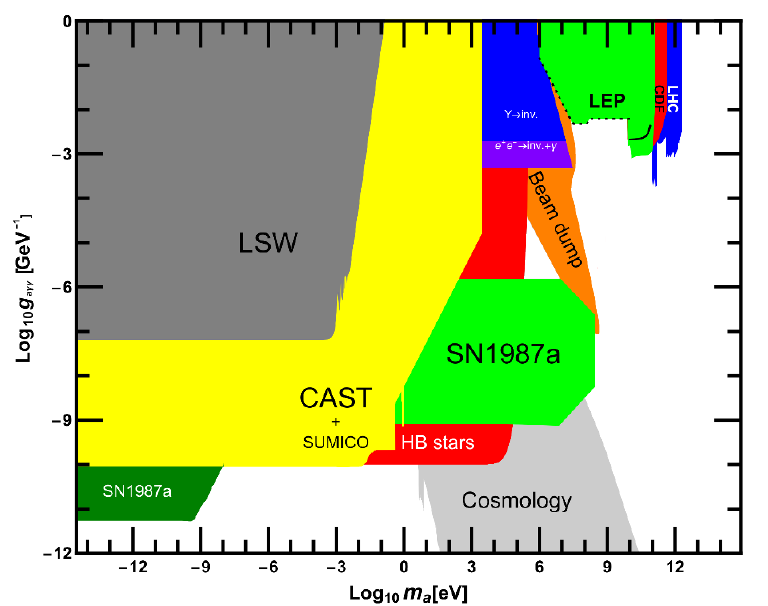
Figure 1. Limits on ALP coupling and mass parameters space compiled by Jaeckel, Jankowiak and Spannowsky [41] and the references therein.